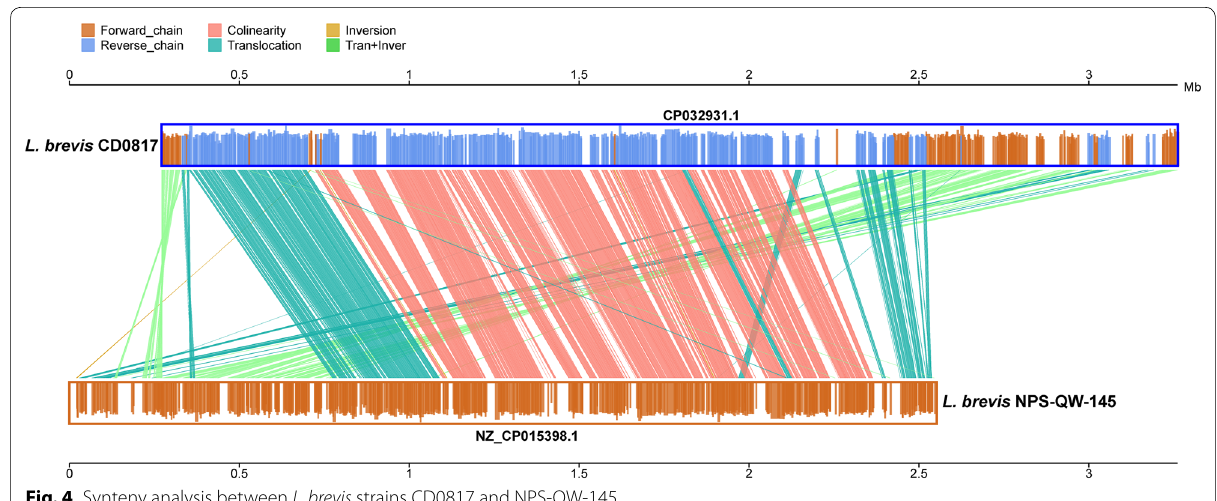
Fig. 4 Synteny analysis between L. brevis strains CD0817 and NPS-QW-145